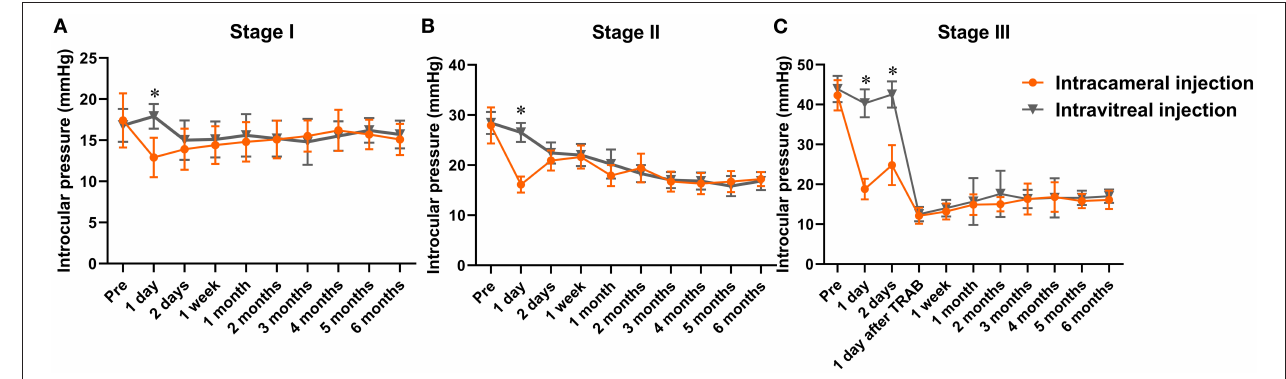
FIGURE 1 | Intraocular pressure profile following conbercept intracameral/intravitreal injection for NVG. *Indicates p < 0.05. NVG, neovascular glaucoma.